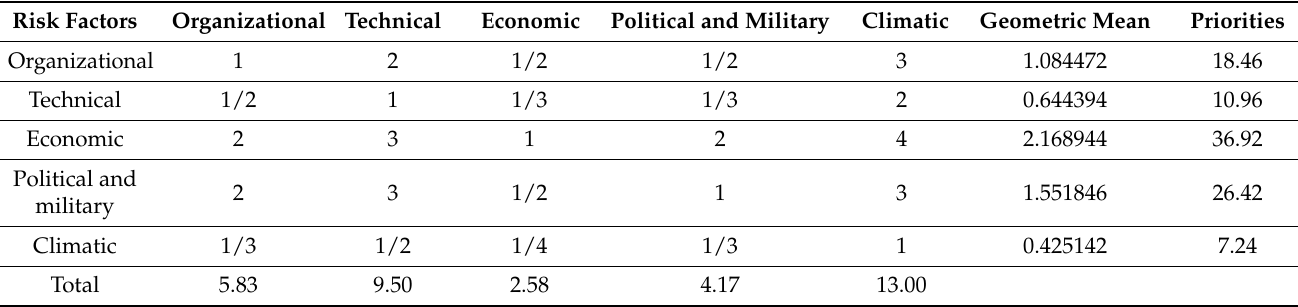
Table 9. Results of expert opinion